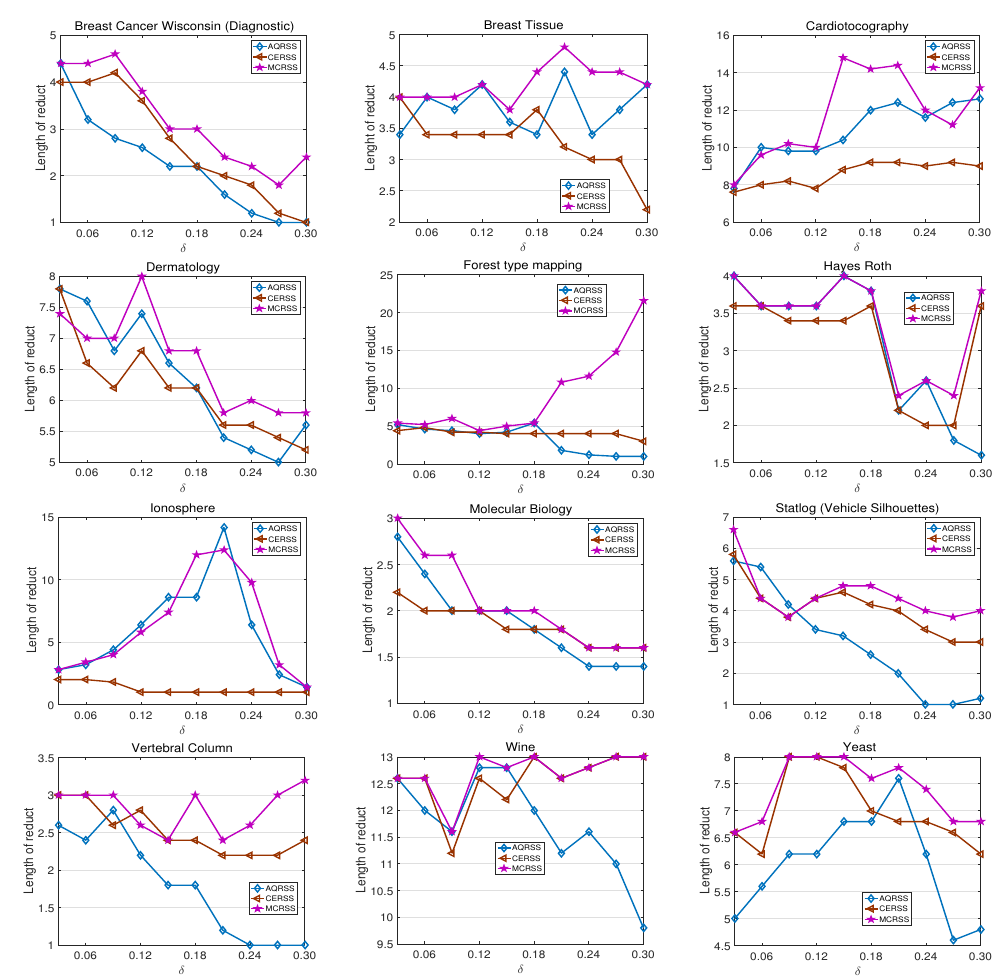
Figure 4. Comparisons of reduct